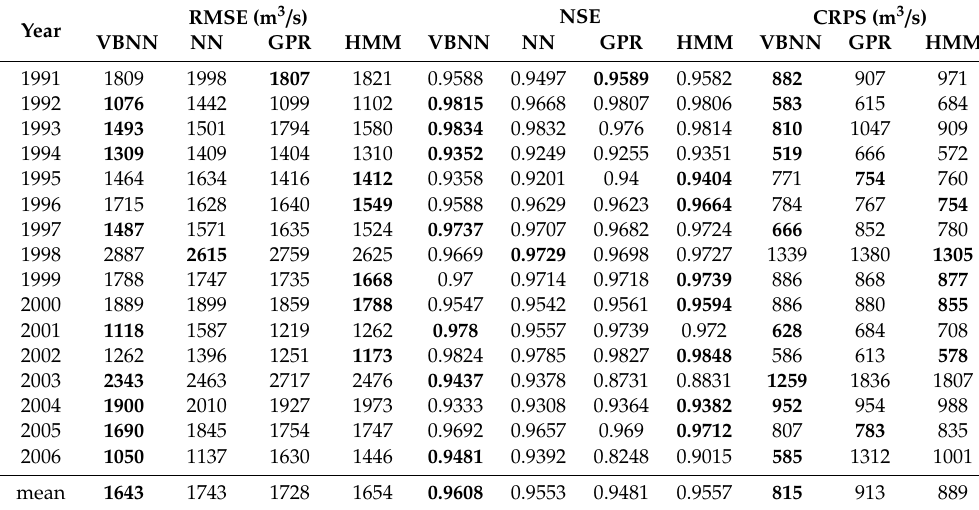
Table 2. The root mean square error (RMSE), Nash–Sutcli ff e e ffi ciency coe ffi cient (NSE), and continuous ranked probability score (CRPS) of VBNN, neural network (NN), Gaussian process regression (GPR), and hidden Markov model (HMM) during the test